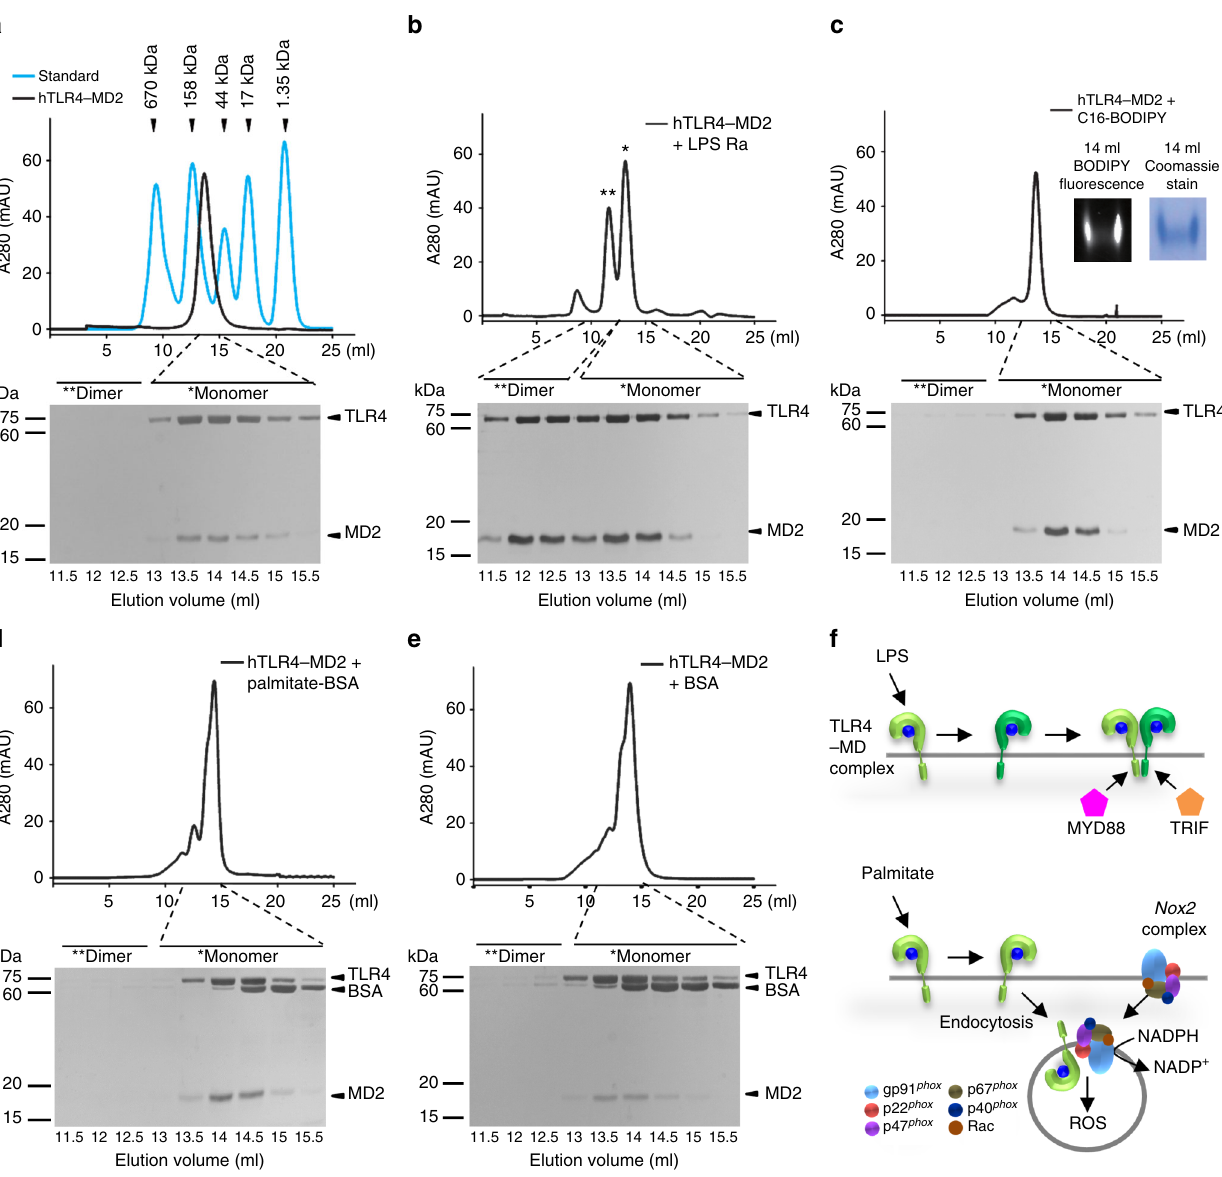
Fig. 6 Monomeric interaction of hTLR4 – MD2 complex in response to palmitate treatment. Dimerization of human TLR4 – MD2 (hTLR4 – MD2) complex mediated by different lipid ligands was examined by size-exclusion chromatography (Superdex 200) and SDS – PAGE with silver staining. a Arrowheads in chromatogram indicate each elution volume of standard proteins (thyroglobulin, 670 kDa; γ -globulin, 158 kDa; ovalbumin, 44 kDa; myoglobin, 17 kDa; vitamin B12, 1.35 kDa). The monomeric hTLR4 – MD2 complexes (~ 90 kDa) were eluted at ~14 ml fraction. b Incubation of hTLR4 – MD2 complex with LPS Ra induced the dimerization of hTLR4 – MD2 complex. The dimeric hTLR4 – MD2 complex by LPS was eluted at 12 ml and the remaining monomeric TLR4 – MD2 complexes were eluted at 14 ml. c – e Incubation of hTLR4 – MD2 complex with C16-BODIPY ( c ), palmitate-BSA ( d ), or BSA ( e ) could not induce the dimerization of hTLR4 – MD2 complexes. Native PAGE followed by illumination at 488 nm and Coomassie staining con fi rmed the binding of C16- BODIPY to hTLR4 – MD2 complex ( c , inset). f Schematic diagram of dimeric or monomeric states of TLR4 – MD2 complex in response to treatments of LPS and palmitate. The dimeric hTLR4 – MD2 complex by LPS requires binding with MyD88 or TRIF, while monomeric TLR4 – MD2 complex by palmitate generates ROS by NOX2 complex. Data are representative of three independent